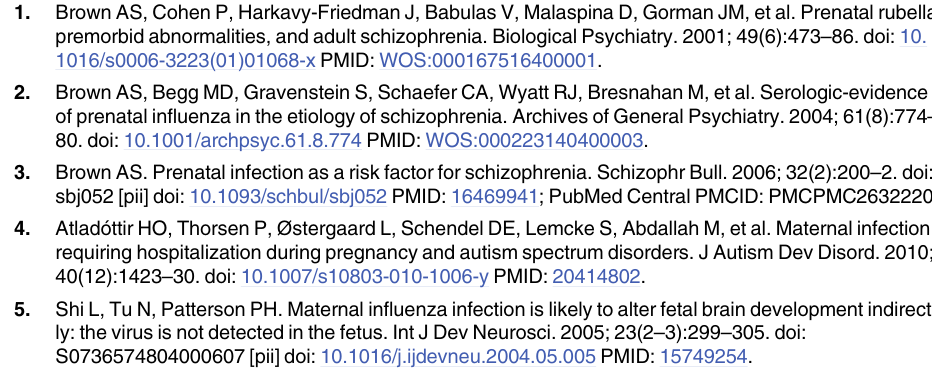
S2 Fig. Correlation of ACTH level in FS with IL-6 level in MS and with LIF level in MS. (A) Correlation of IL-6 level in MS and ACTH level in FS. (B) Correlation of LIF level in MS and ACTH level in FS. Maternal serum and fetal serum were analysed at 3 h after MIA at 12.5 days post-coitum (dpc). MIA was induced by an intraperitoneal (i.p.) injection of either 4 or 20 mg/kg polyriboinosinic-polyribocytidylic acid [poly (I:C)]. ontrols were injected with an equal volume of saline (0.01 ml/g body weight). Number of dams = 3 or 4 in each group. S1 Table. Parameters for stereological analysis. The estimation of volume and total cell num- ber of the cerebral cortex at 18.5 days post-coitum (dpc) was performed using nonbiased ste- reological method using Stereo Investigator (version 10; Micro BrightField, Williston,